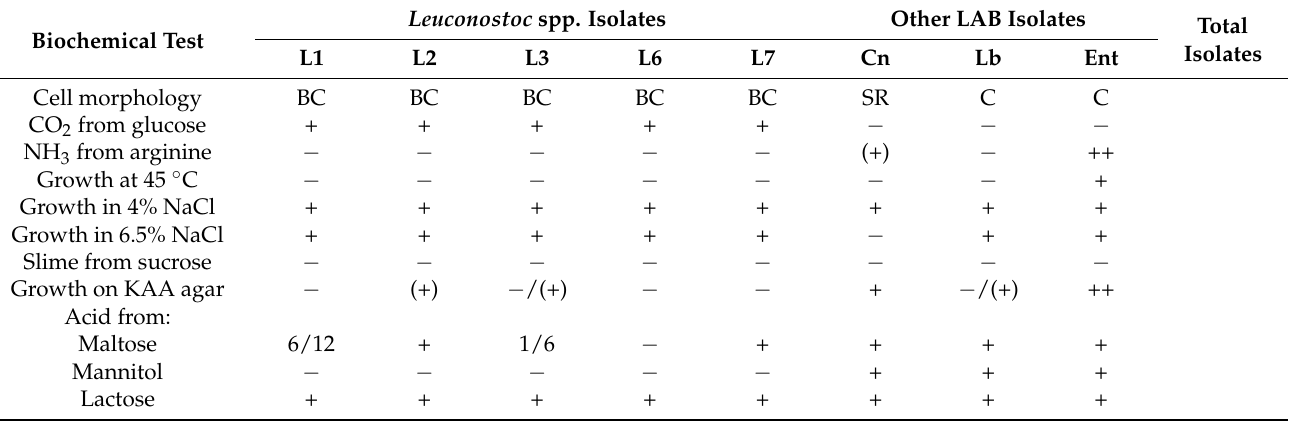
Table 4. Biochemical characterization of additional 44 representative LAB isolates recovered from MRS and TSAYE agar plates of spoiling (day 15) Anthotyros whey cheese products stored at 4 ◦ C in